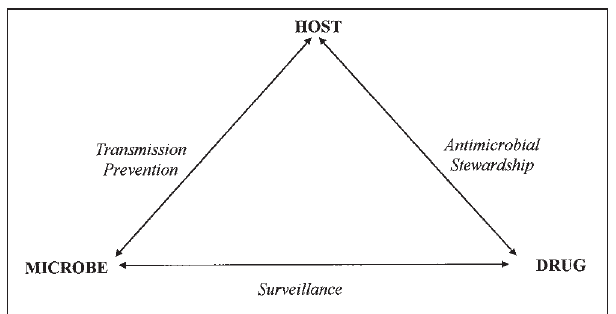
Figure 1) Controlling antimicrobial resistance in the classic host- microbe-drug